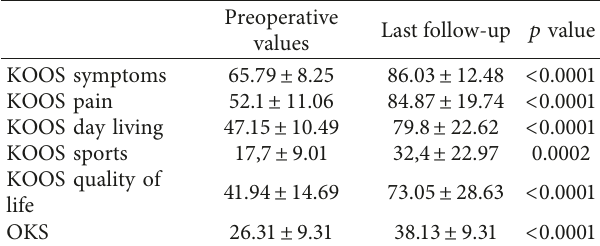
Table 3: Preoperative and postoperative clinical outcomes according to the KOOS and